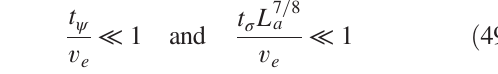
so that fermion and Ising-anyon tunneling across the con- striction contribute only small corrections to the amplitude in Eq. (46).